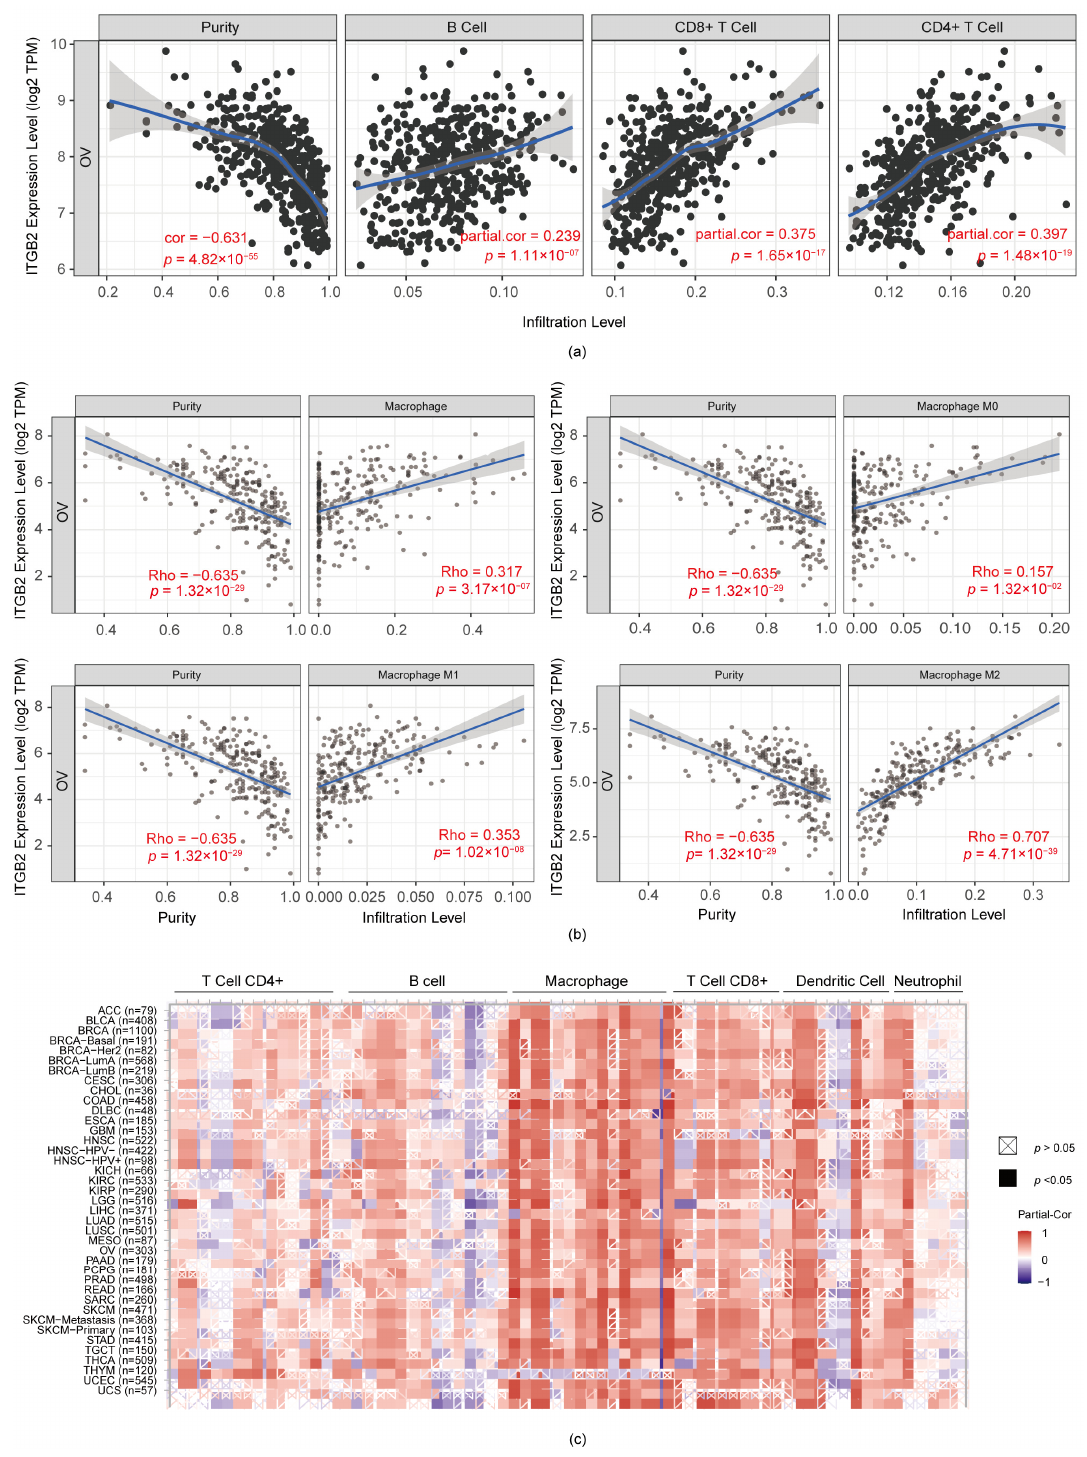
Figure 4. Relevance between ITGB2 expression and infiltration of classical immune cells. ( a ) Relevance between ITGB2 and a variety of infiltrating immune cells (B cells, CD4+/CD8+ T cells); ( b ) Relevance between ITGB2 and macrophages, including: macrophages, M0 macrophages, M1 macrophages, and M2 macrophages; ( c ) Relevance between ITGB2 expression and classical immune cells in other cancer types in patients.